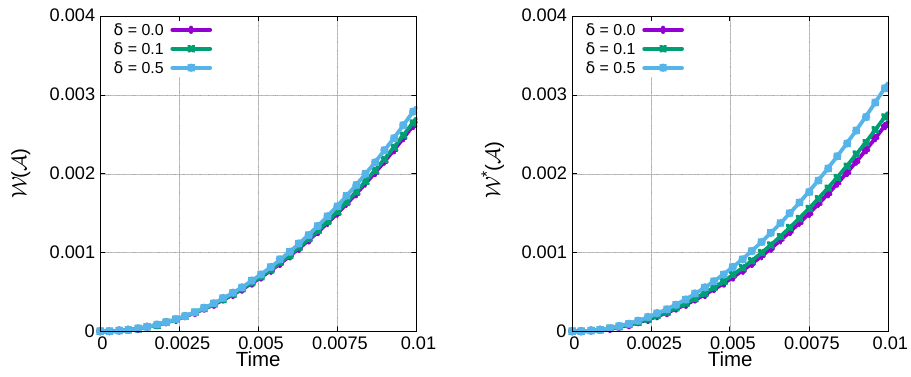
Figure 7. Profile of W ( A ) ( left ) and W ∗ ( A ) ( right ) in subdomain A during the loading